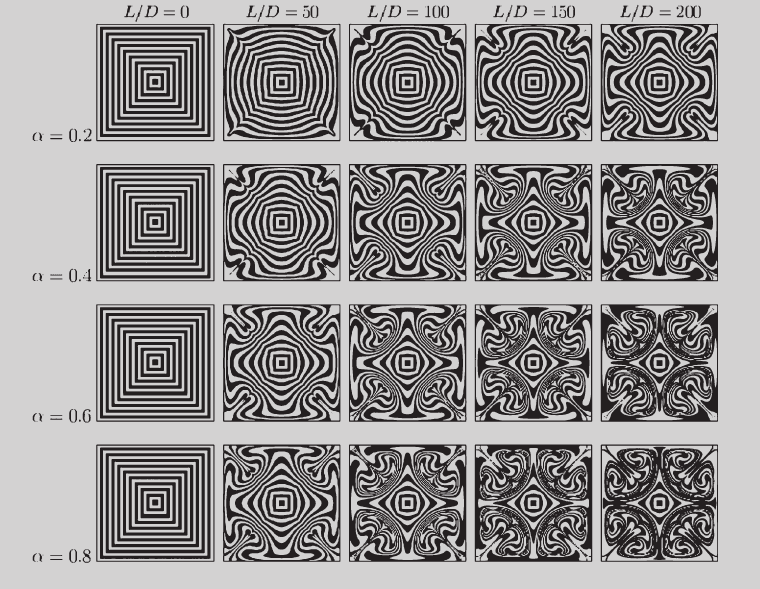
Figure 9: Numerical simulations com- paring layer rearrangement as a function of distance traveled down a square channel. The viscoelasticity was changed by changing the non-linear a parameter in the one mode Giesekus model from 0 to 0.8 with steps of